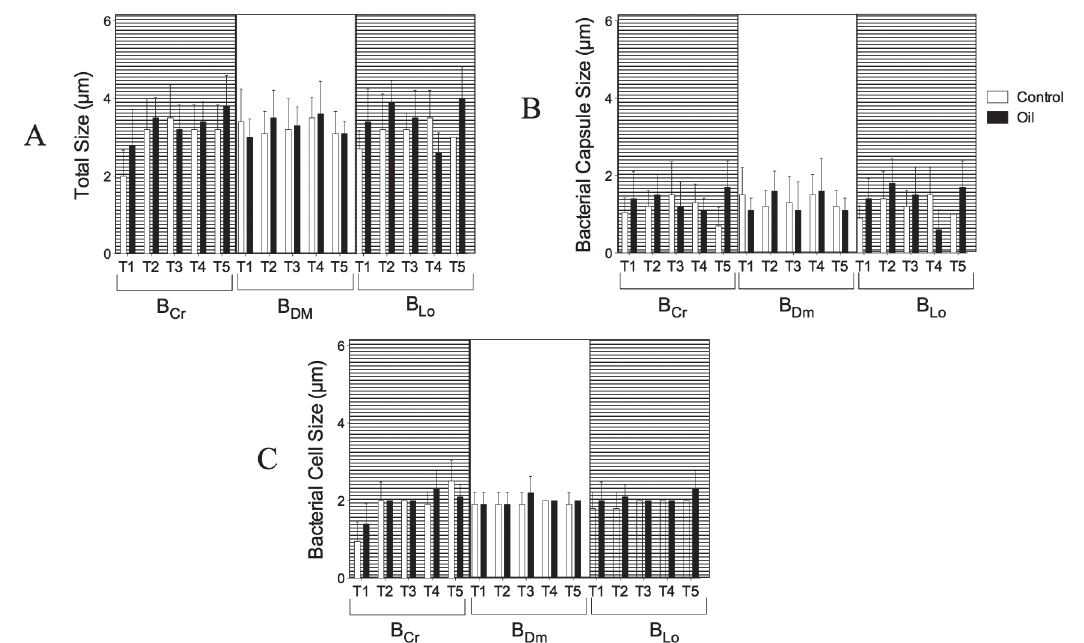
Figure 4 - Bacterial proportions measured during oil degradation. A- Total size; B- Bacterial capsula size; C- Bacterial cell